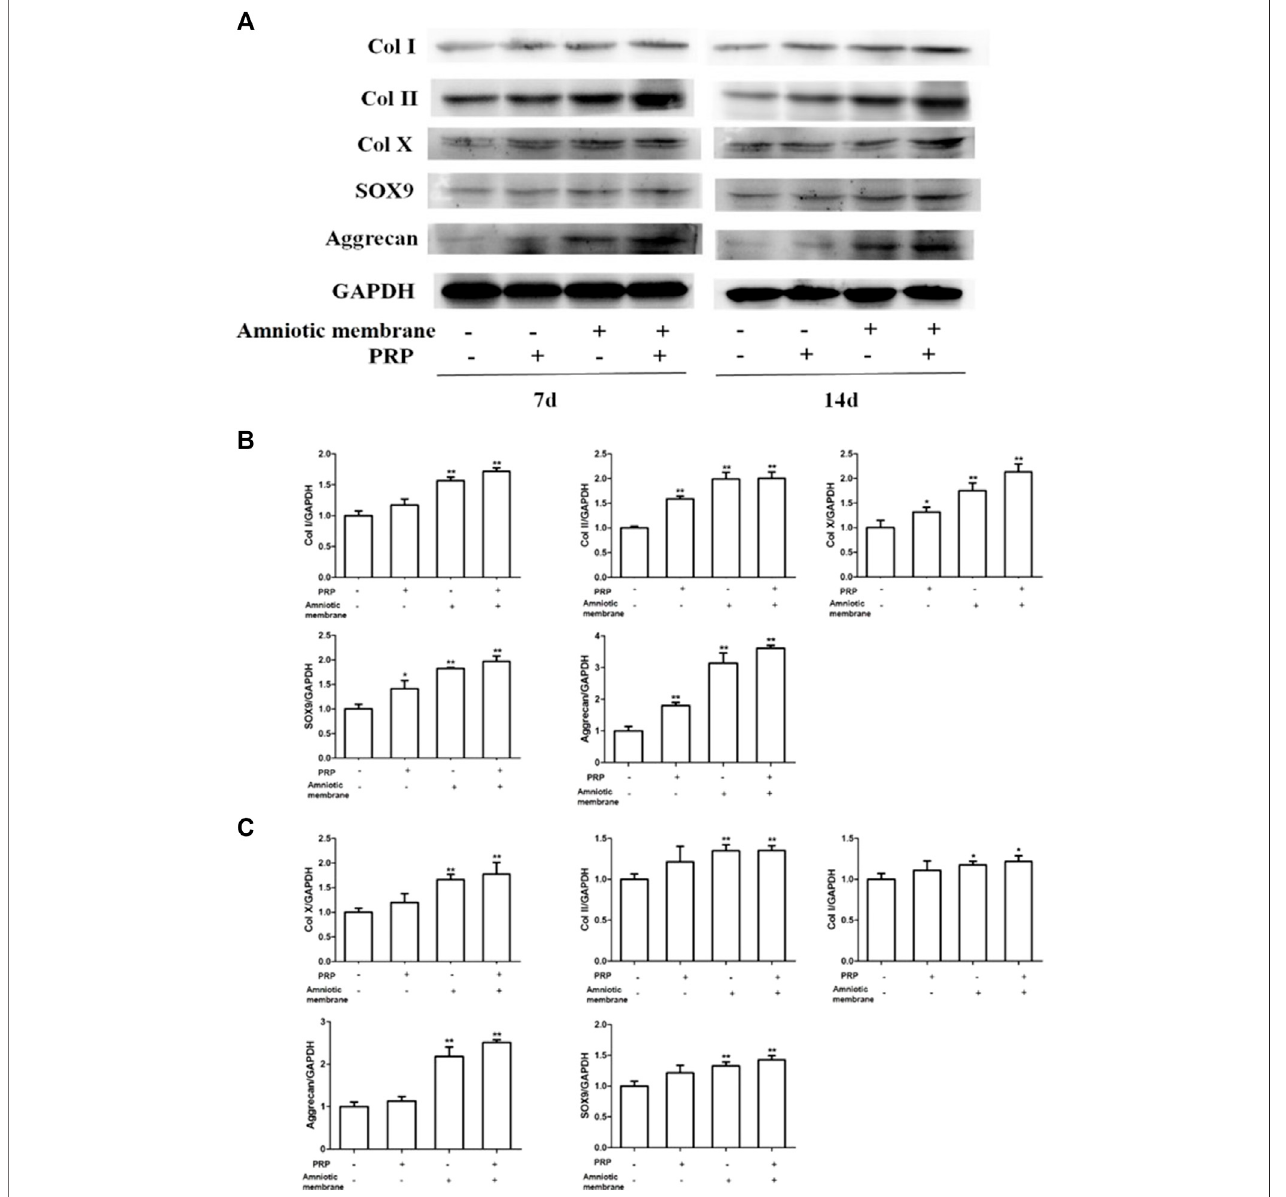
FIGURE 4 | The combination of amniotic membrane and PRP scaffolds exhibited the most signi fi cant increase in the translational level of factors related to cell growthanddifferentiationinADSCs.ADSCswereculturedunderthetreatmentofdifferentscaffolds.TheproteinexpressionlevelsofcollagenI/II/x,Sox-9,andaggrecan were detected by Western blot on day 7 and day 14. (A) The detection of protein level of collagen I/II/x, Sox-9, and aggrecan by Western blot on day 7 and day 14. The expression of GAPDH was considered as the loading control. Two biological repeats were conducted in this part, and the most representative bands were shown for every targeted band. (B,C) The bar chart in this fi gure shows the quanti fi cation of the bands level of each gene on (B) day 7 and (C) day 14 in (A) by Lab image software. ** p < 0.01, * p < 0.05.